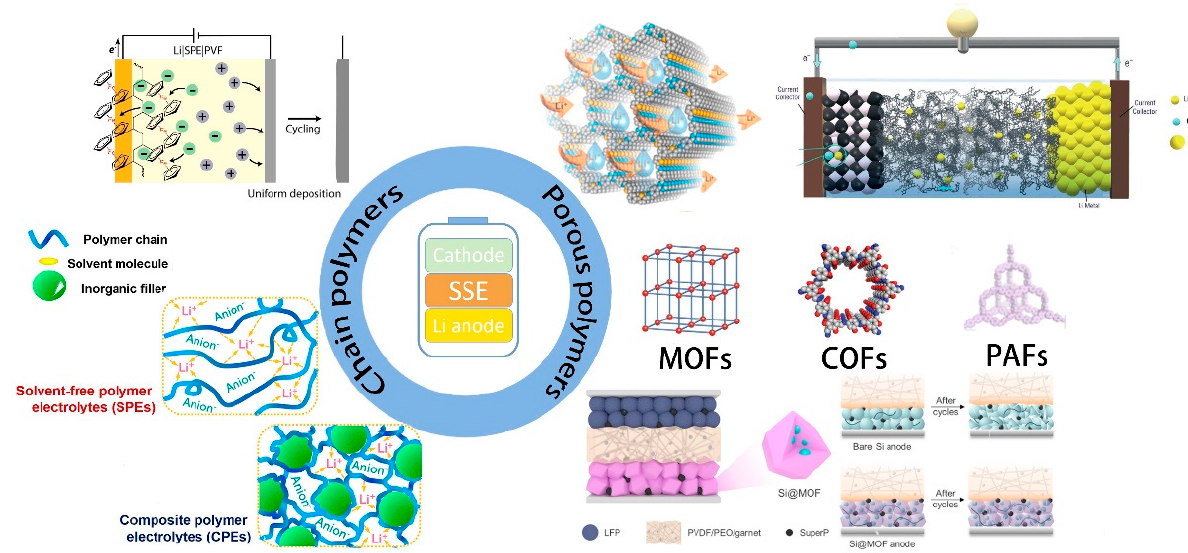
Figure 1. Applications and contributions of polymers in All − Solid − State Rechargeable Lithium Battery. Adapted with permission from ref. [27]. Copyright 2019 Elsevier. Ref. [28]. Copyright 2021 American Chemical Society. Ref. [29]. Copyright 2019. John Wiley and Sons. Ref. [30]. Copyright 2022 American Chemical Society.